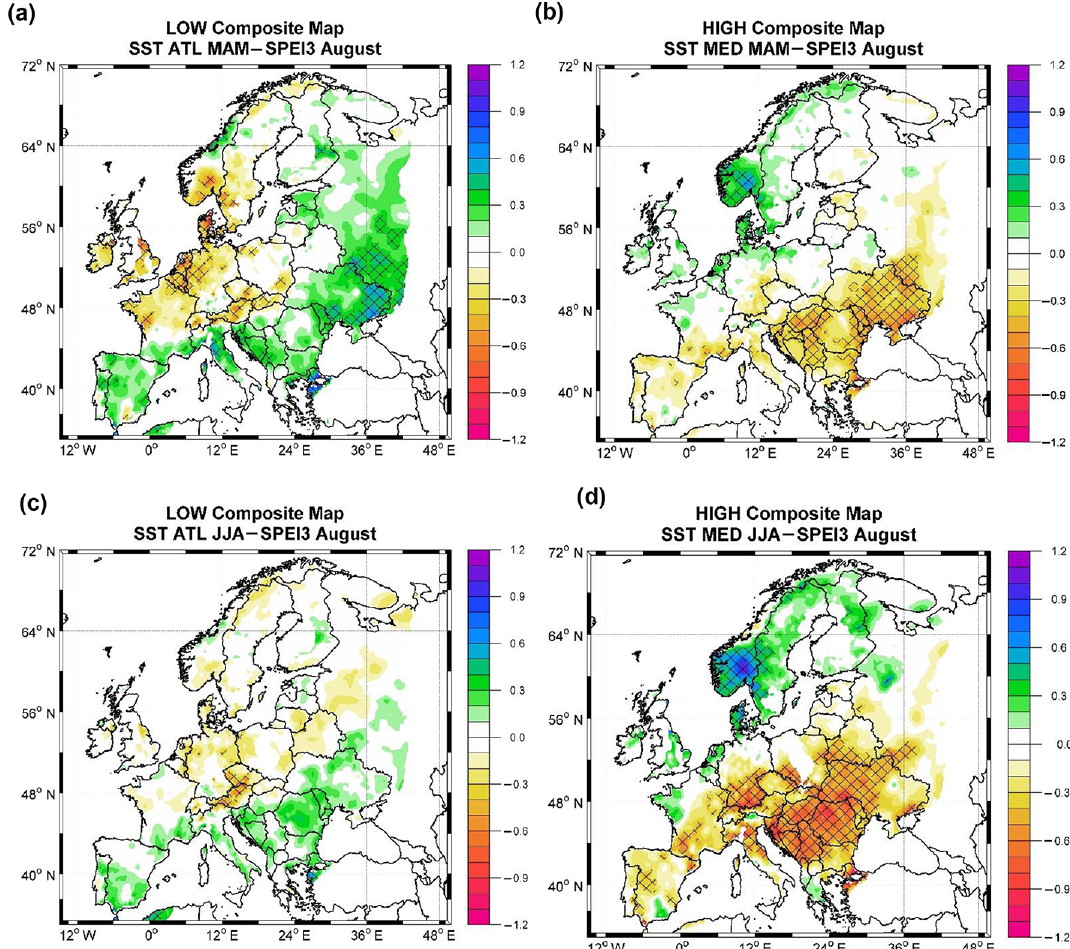
Figure 12. (a) The low (SST cold index ≤ 0.75 standard deviation) composite map between the spring (MAM) Atlantic SST cold index (defined as the MAM-averaged SST over the black box in Fig. 9a and the August SPEI3 field). (b) The high (SST warm index ≥ 0.75 standard deviation) composite map between the spring (MAM) Mediterranean SST warm index (defined as the MAM-averaged SST over the black box in Fig. 9b and the August SPEI3 field). (c) is the same as (a) but for summer (JJA) Atlantic SST and (d) is the same as in (b) but for the summer (JJA) Mediterranean SST. The hatching highlights significant values at a confidence level of 95%. Analyzed period: